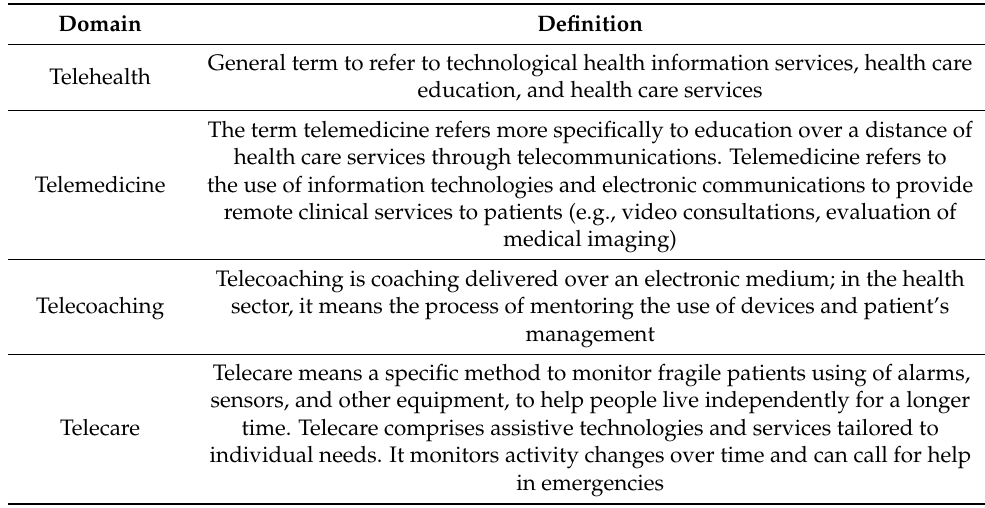
Table 1. Facets of